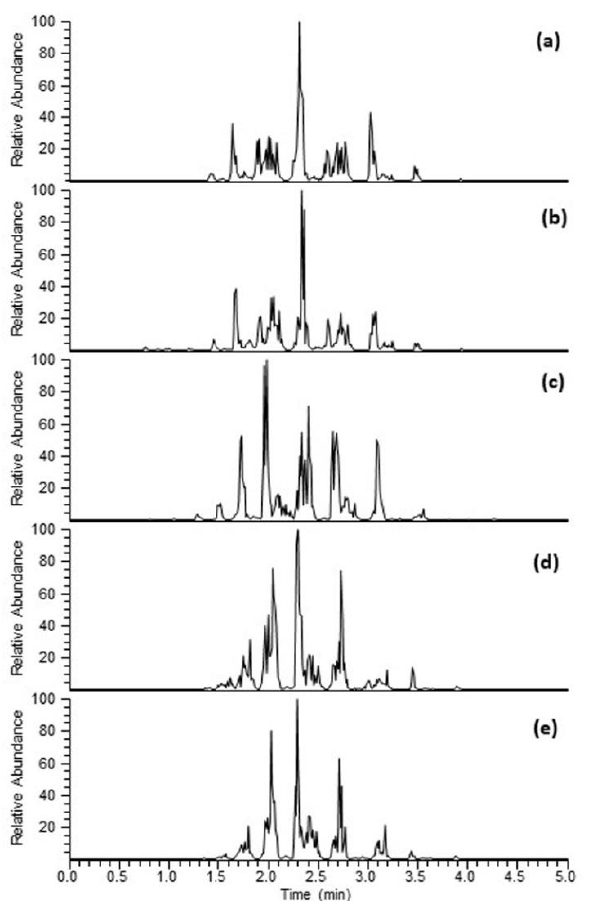
Figure 3. Base peak chromatograms of neutral lipid fraction of oil derived from hemp seeds, hearts, hulls, cake and hemp oil in positive mode ESI-MS. ( a ) Hemp hearts, ( b ) hemp cake, ( c ) hemp seed hulls, ( d ) hemp oil and ( e ) hemp whole seeds. Table 2. Heat map of triacylglycerols (TAGs) identified in oil extracted from hemp hearts (HSHE), hemp whole seeds (HSWH), hemp cake (HSCA), hemp seed hulls (HSHU) and cold-pressed hemp oil